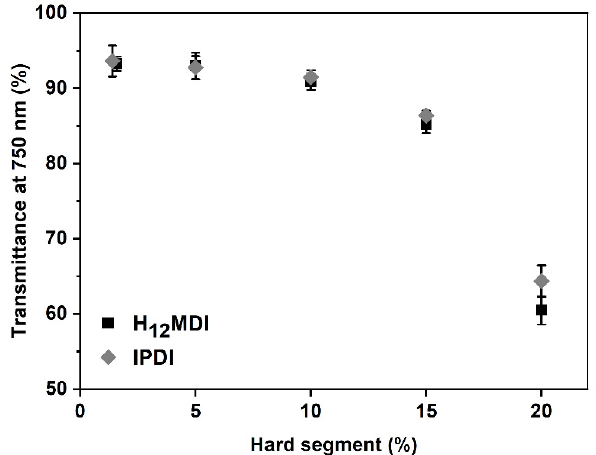
Figure 4. Influence of HS content on transmittance of PSU elastomer films synthesized from H 12 MDI and IPDI. Transmittance at 750 nm is higher than 90% in the PSU elastomers with HS contents between 1.4% and 10%. PSU elastomers with HSs contents of 15% and 20% are less translucent and have transmittance values of approximately 85% and 60%, respectively. The error bars represent the standard deviation from three measurements.